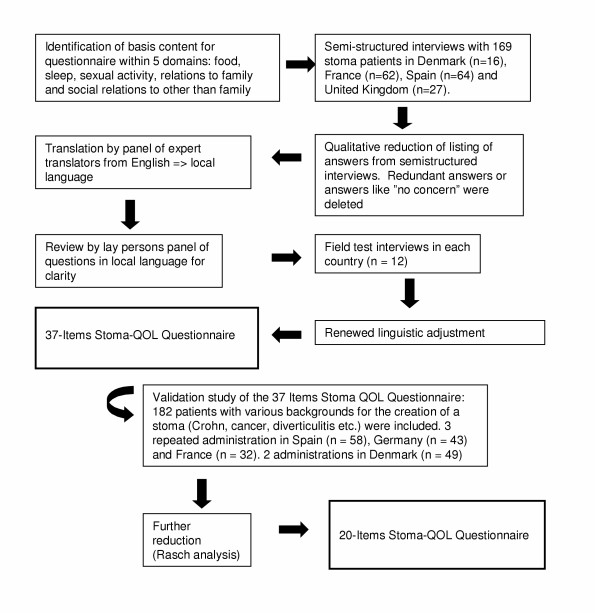
Development of the Stoma-QOL questionnaire.